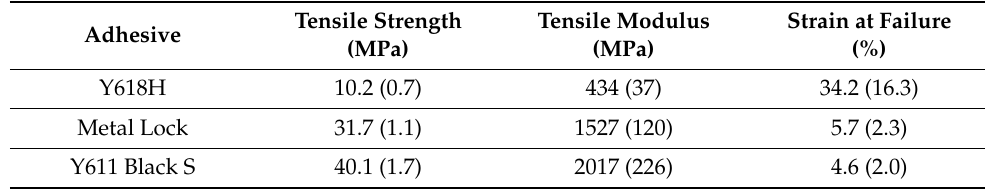
Table 1. Mechanical properties of Y618H, Metal Lock, and Y611 Black S adhesive (standard deviation is mentioned in